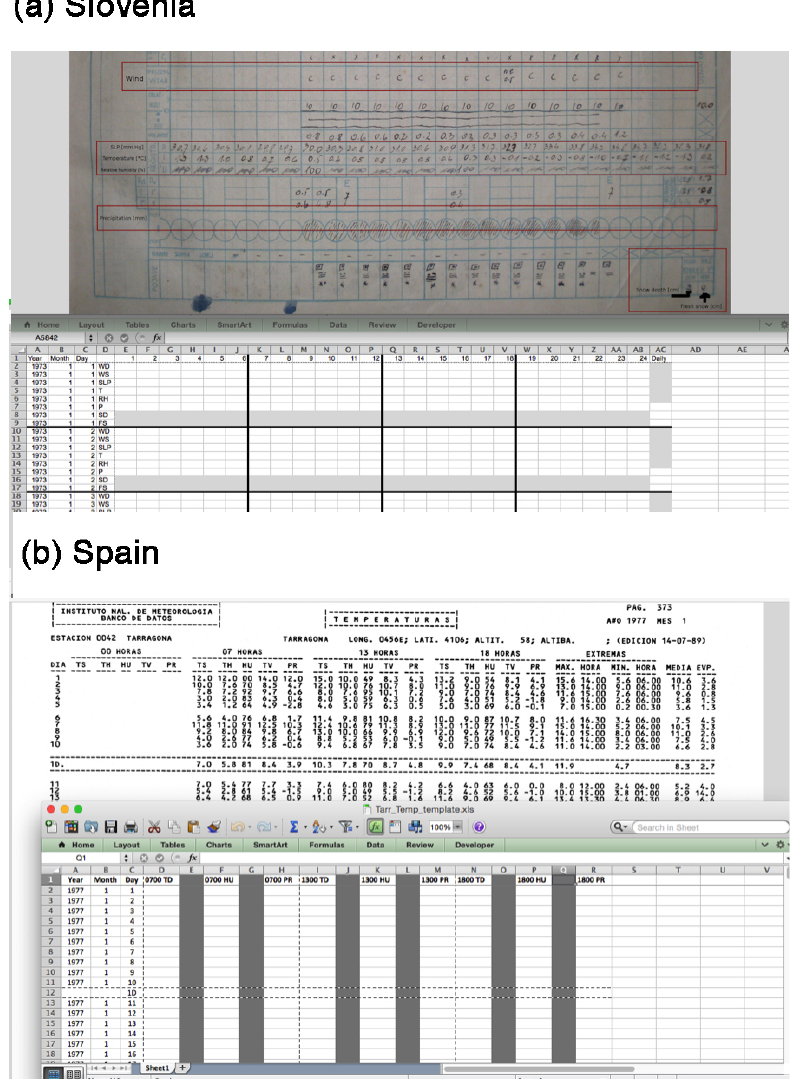
Figure 3. Examples of the templates used in data digitisation. Shaded rows and columns in the templates represent data that are not to be digitised. (a) The template for the Slovenian data sources picks out the rows that require digitising: wind direction (WD), wind speed (WS), atmospheric pressure (SLP), temperature (T), relative humidity (RH), precipitation (P), snow depth (SD) and fresh snow (FS). Note that rows for the daily values are formatted to match the location of the data in the original source. (b) The template for temperature data from Spanish data sources with the columns labelled with variables and hours: dry bulb temperature (TD), relative humidity (HU) and dew point temperature